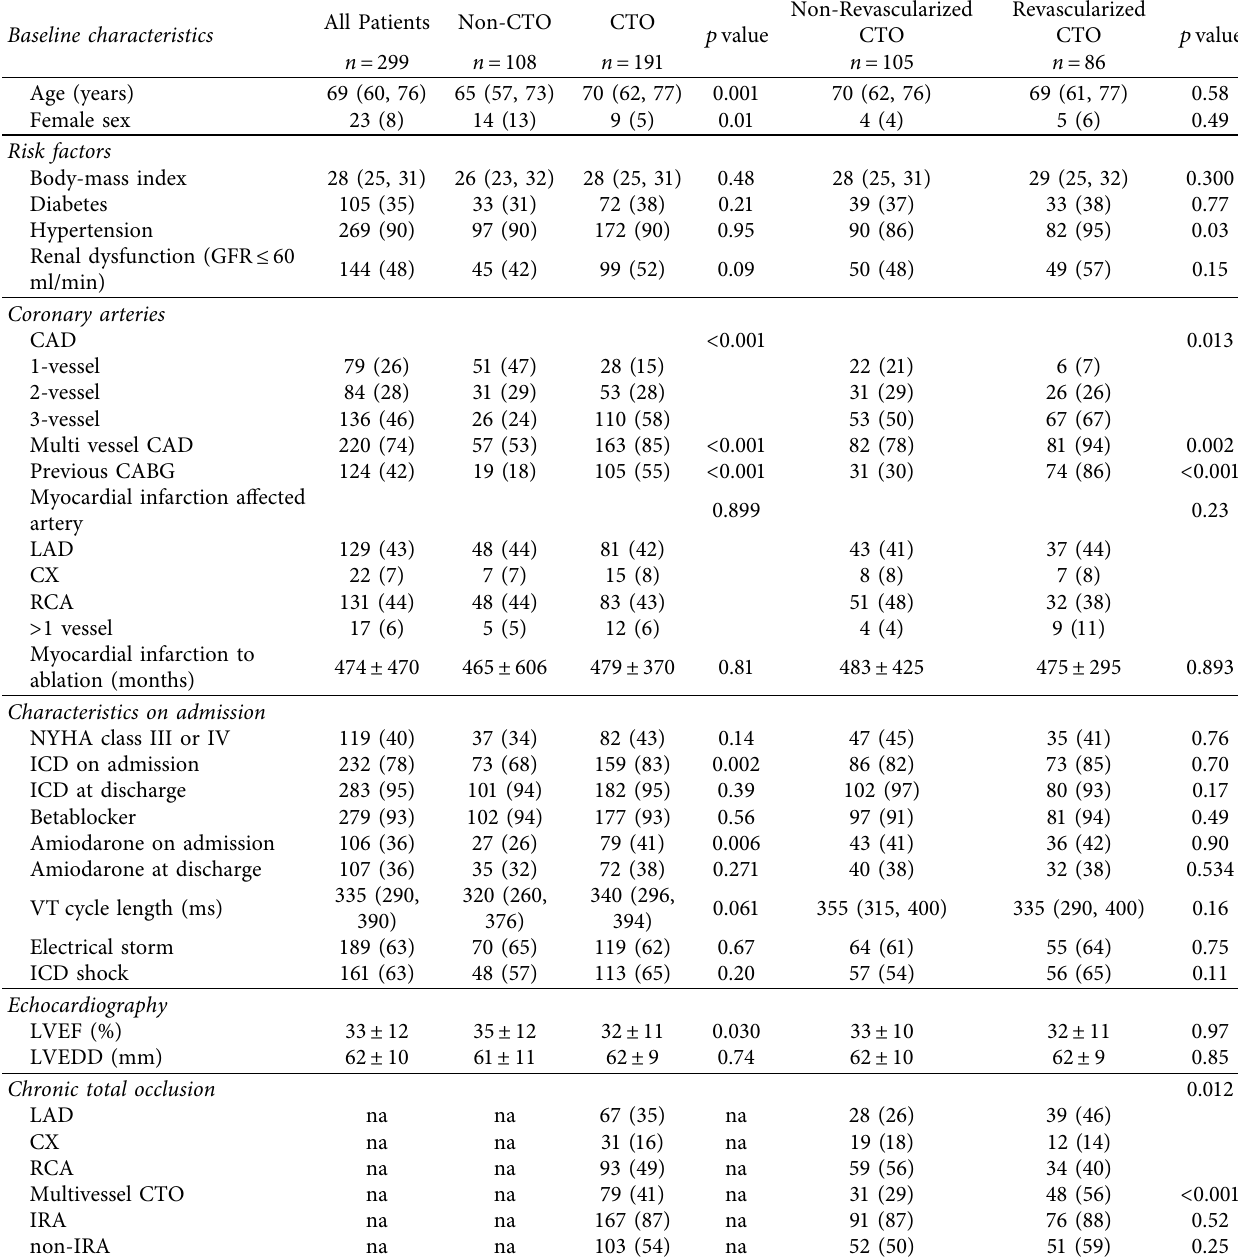
Table 1: Baseline parameters for CTO and non-CTO as well as nonrevascularized and revascularized